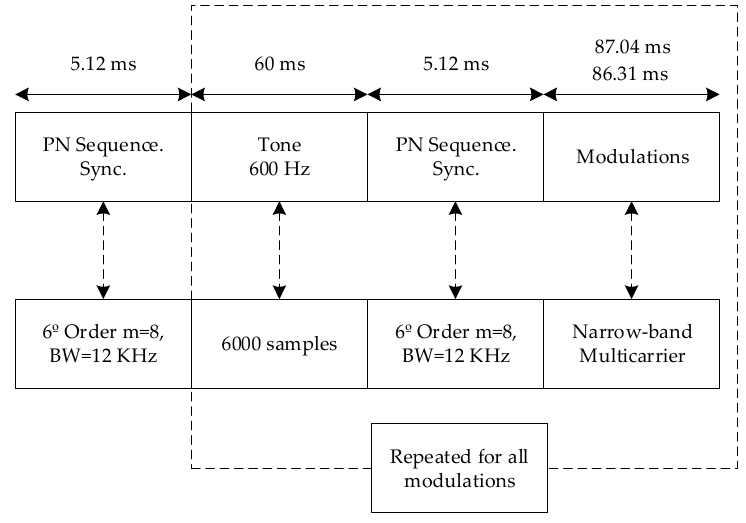
Figure 4. Frame design for each modulation.